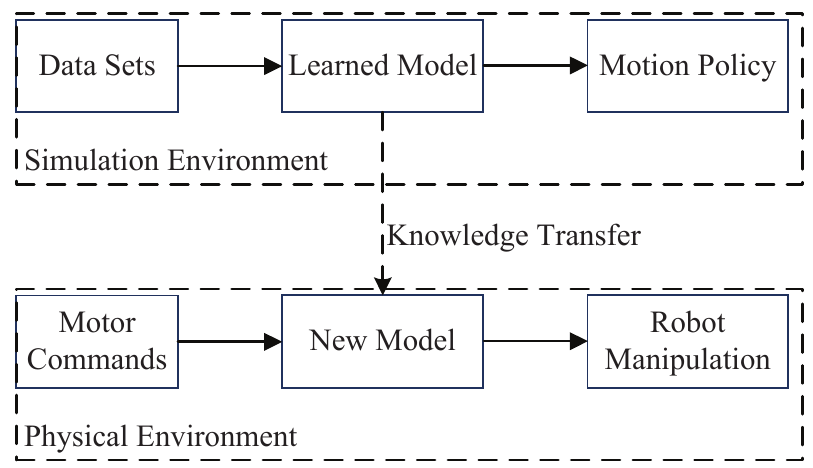
Figure 4. Principle of transfer learning for robot